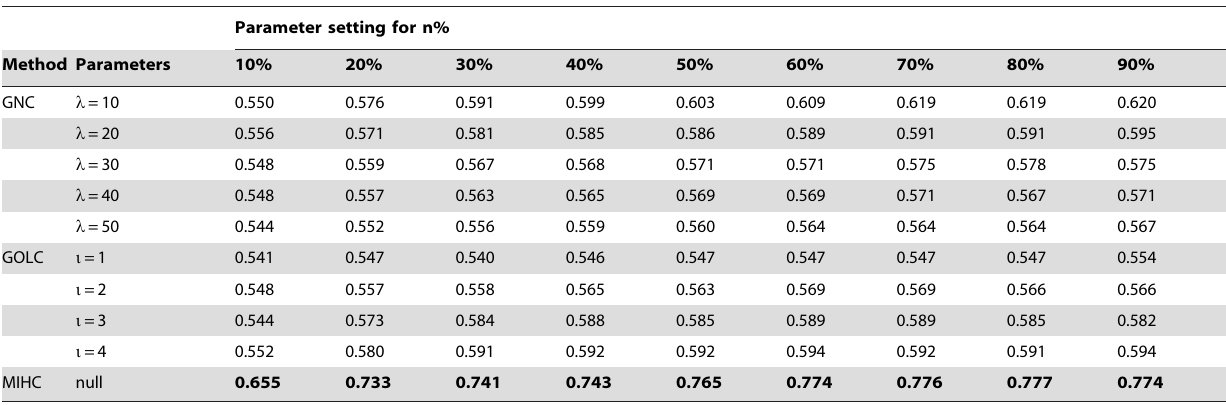
Table 3. Average AUC obtained from cdc28 dataset by MLKNN.